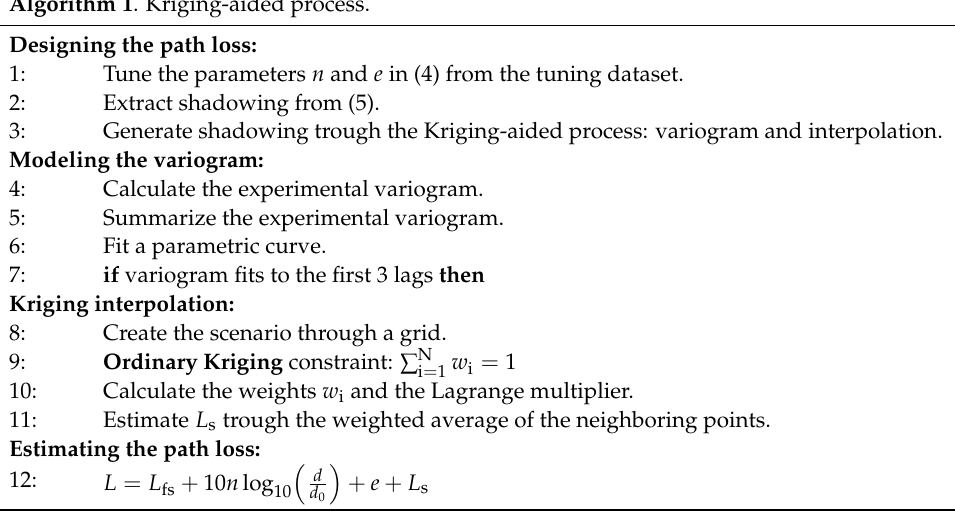
Algorithm 1 . Kriging-aided